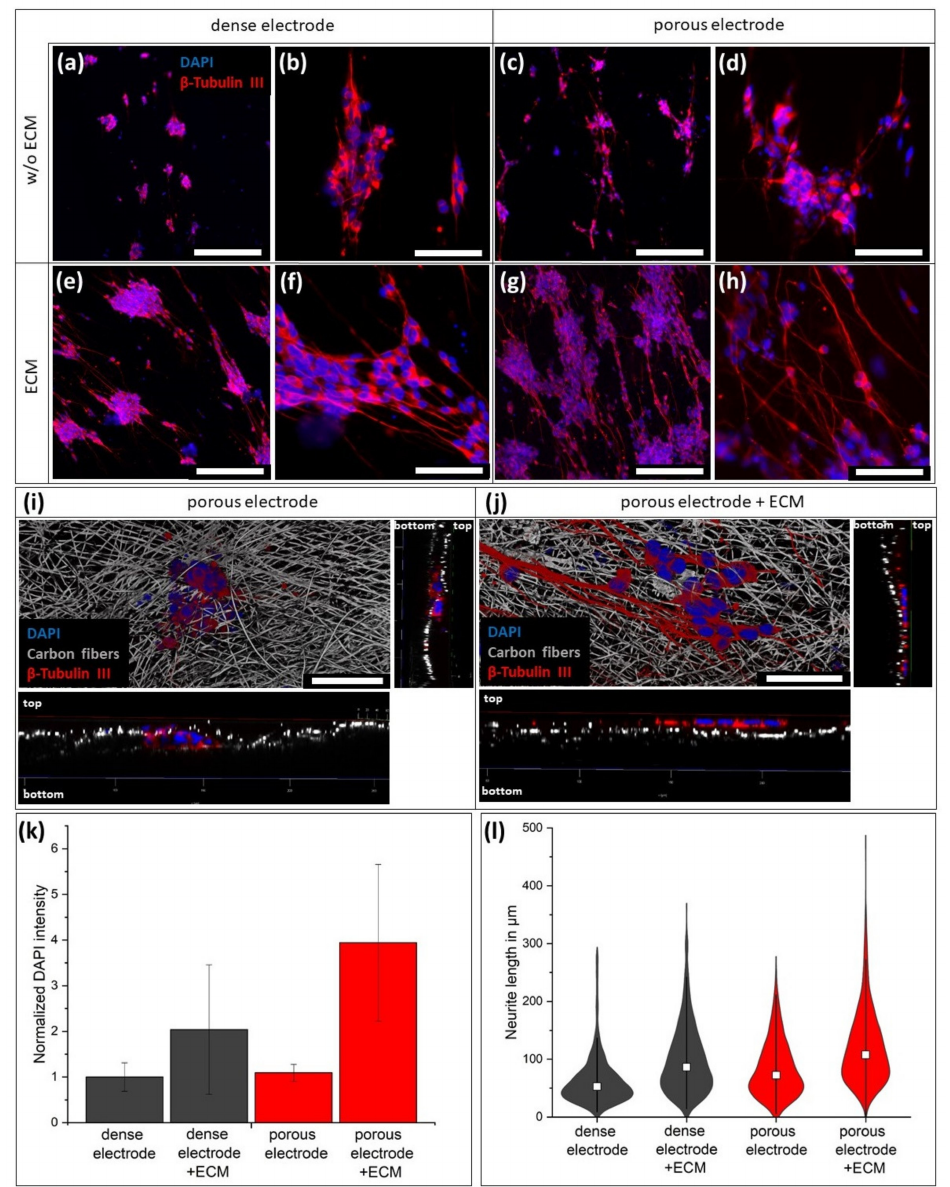
Figure 4. Behavior of SH-SY5Y cells on the ECM modified electrodes. ( a – d ) IF staining against β -tubulin III presented a reduced cell adhesion on the bare carbon nanofiber electrodes compared ( e – h ) to the ECM-modified electrodes. ( a , b , e , f ) describe the dense electrodes and ( c , d , g , h ) the porous electrode. Confocal imaging (confocal reflection imaging of the carbon fibers) showed the cells inside the bare porous electrode ( i ), while the ECM modification on the porous electrode prevented cellular penetration of the surface ( j ). Scale bars correlate to 200 µ m in ( a , c , e , g ) and to 50 µ m in ( b , d , f , h – j ). Quantification of the average DAPI intensity on at least 20 fluorescence images with subsequent normalization to bare dense carbon fiber electrode ( k ). Violin plot of measured neurite length of β -tubulin III-fluorescence image in a total area of 16.4 mm 2 ( l ). White boxes represents the average neurite length and the breadth of the violin body is related to the number of measured